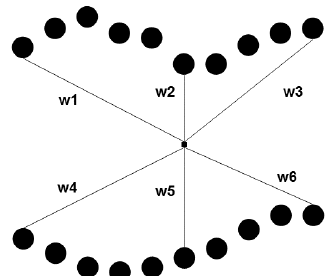
Figure 4. Line envelope width of a single sample. w1 ... w6 are the distance between the sample’s centroid and six points on the